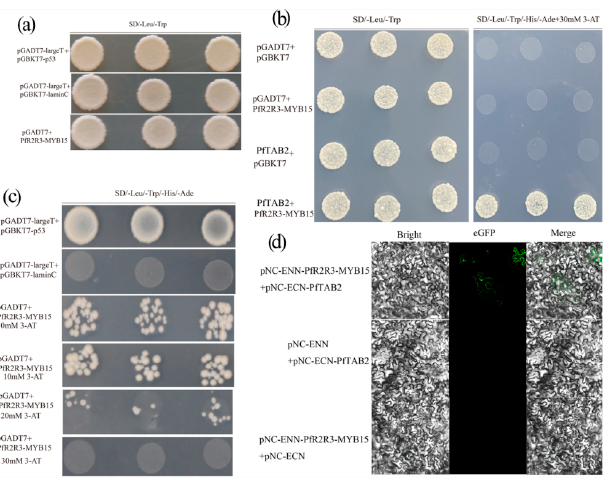
Figure 8. PFR2R3-MYB15 interacted with PfTAB2 . ( a ) pGADT7-largeT/pGBKT7-p53 were positive control, while pGADT7-largeT/pGBKT7-laminC were negative control. ( b ) 0, 10, 20, 30, and 40 mM 3-AT were used for PfR2R3-MYB15 self-activating activity screening. ( c ) PfR2R3-MYB15 interacted with Paulownia_LG3G001014 ( PfTAB2 ) by Y2H screening. ( d ) PfR2R3-MYB15 interacted with